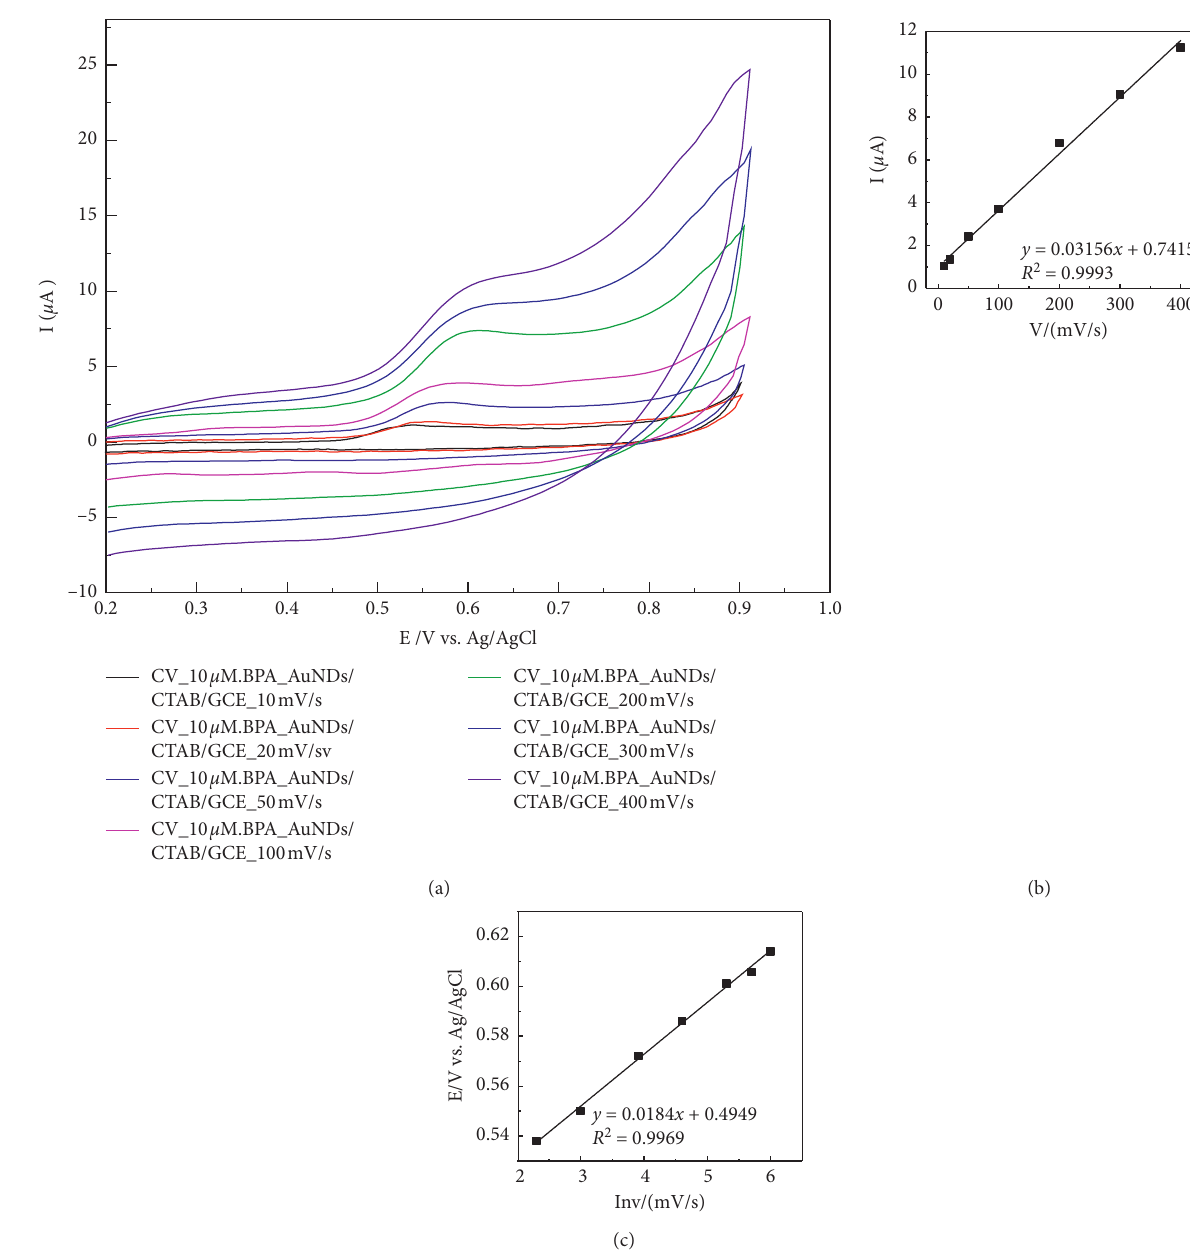
Figure 4: (a) CVs of BPA 10 µ m in PBS pH 7 recorded on AuNDs/CTAB/GCE at different scan rates ( ] ): 10, 20, 50, 100, and 200mVs − 1 . (Inset) Relationship (b) between anodic peak currents and scan rate and (c) between potentials and ln( ]